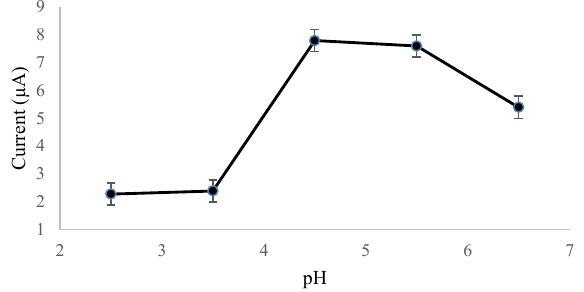
Figure 1. Effect of pH on a 1.0ppm standard cadmium solution in an acetate buffer with different pH values.